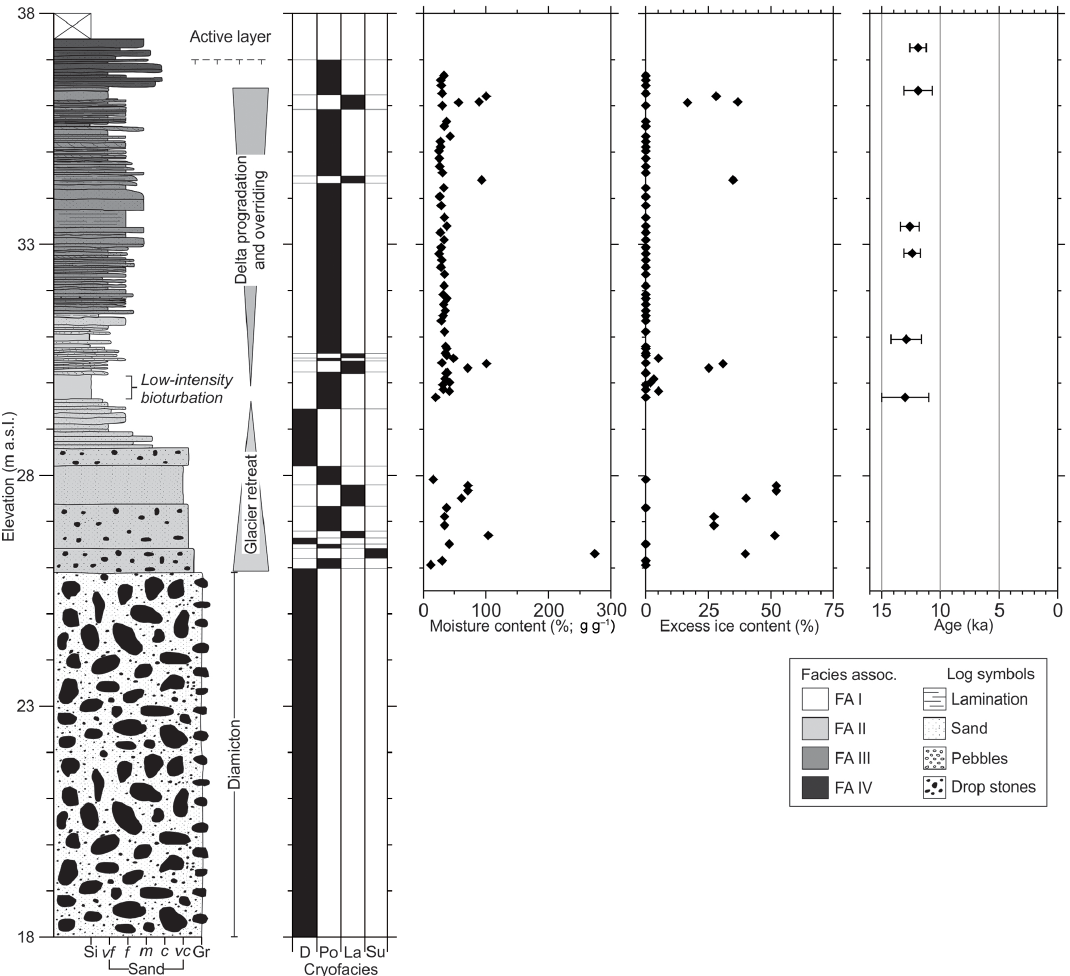
Figure 7. Log for C1 illustrating vertical variations in sediment grain size, facies associations, ground-ice characteristics and OSL ages. D, Po, La, and Su denote disturbed sections, pore, layered, and suspended cryofacies,